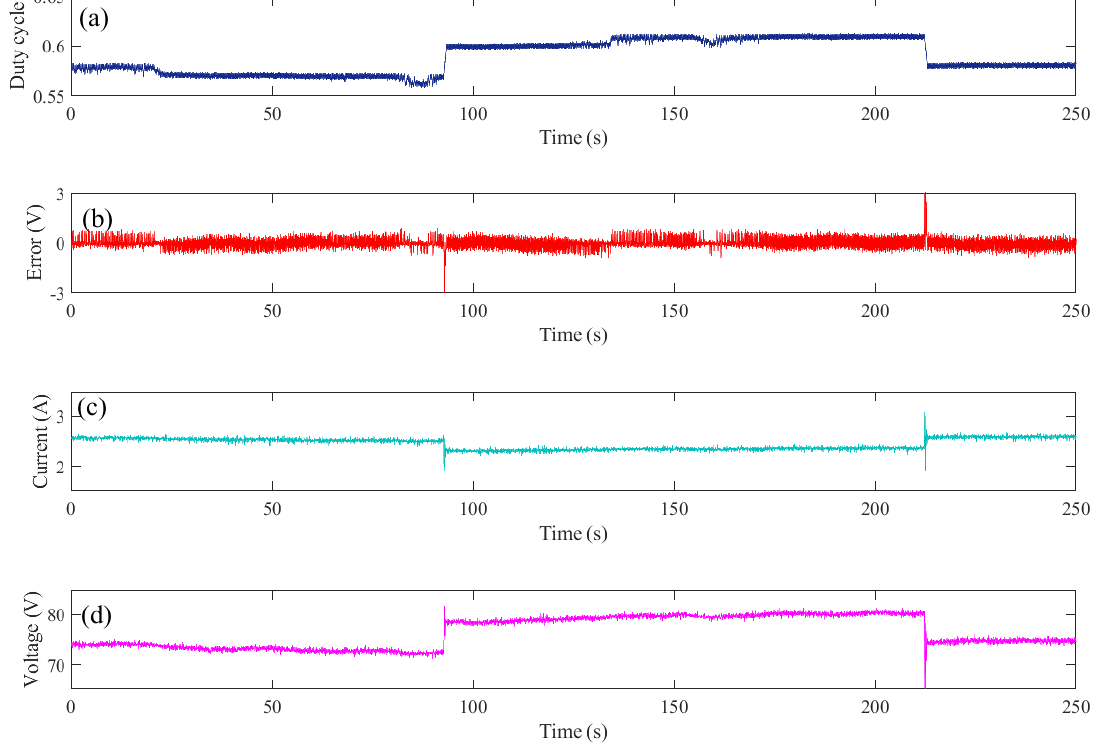
Figure 18. MPPT based on RNN and SMC: ( a ) Duty cycle; ( b ) Error; ( c ) Boost converter output current ( I out ); ( d ) Boost converter output voltage ( V out